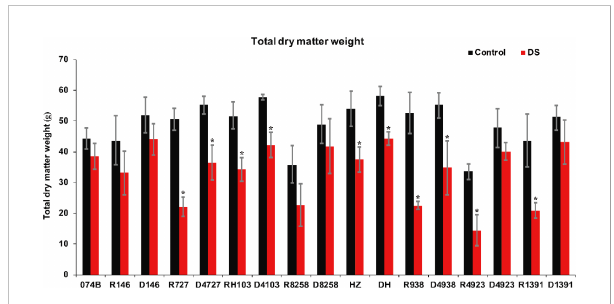
FIGURE 7 Total dry matter weight of restorer lines and hybrid progeny under drought stress treatment conditions. DS represents drought stress treatment. Error bars denote standard deviations ( n = 3); “ * ” stands for signi fi cance between drought stress and control condition in the same cultivar (p ≤